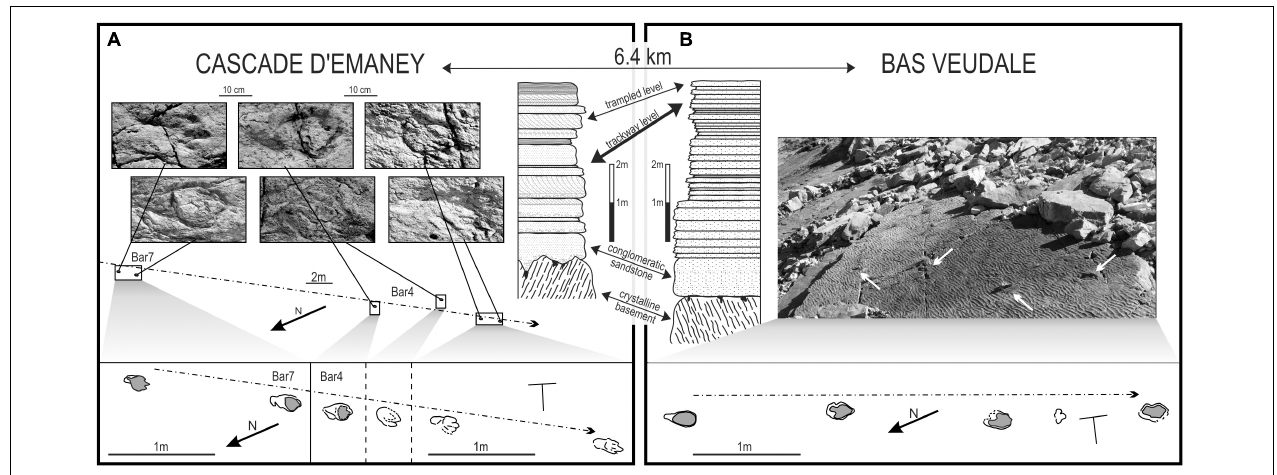
FIGURE 2 | Comparison of the Cascade d’Emaney and Bas Veudale trackway segments, with trackway settings and sedimentological settings. The Cascade d’Emaney trackway (A) is composed of two sections (Bar 4 and Bar 7) separated by a gap of 18 m, with six footprints preserved; the Bas Veudale trackway (B) is composed of a single section composed of four footprints. Details of the trackways are depicted in the boxes at the bottom of the figure. Stratigraphic relationships between both sites: the pre-alpine basement (crystalline basement) is made up of various metamorphic rocks, whereas the autochtonous Triassic sediments include conglomeratic sandstones at the base followed by various sandstones with cross stratifications, ripple-marks, and dessication cracks; clayey mudstones interrupted by thin quartzitic sandstone layers, both with ripple-marks; and dolomitic limestones, dolomites and cargneules. The trackway level studied here (bold double-headed arrow) is located below a trampled level visible some tens of meters from both studied trackways. TABLE 1 | Measurements (in centimeters) of Isochirotherium herculis footprints from three Triassic localities in SW Switzerland. Locality Trackways Dip